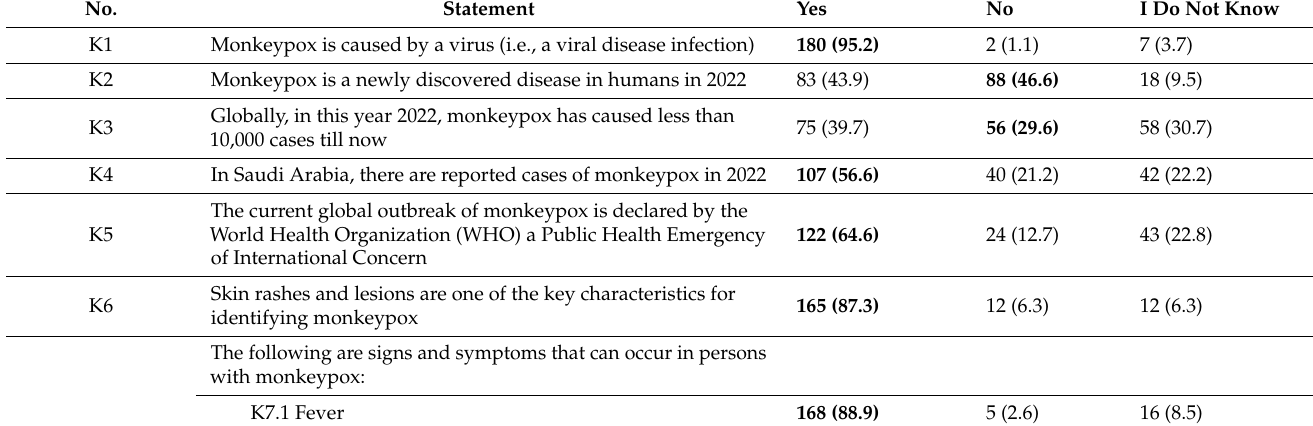
Table 3. Participants’ responses to the knowledge statements